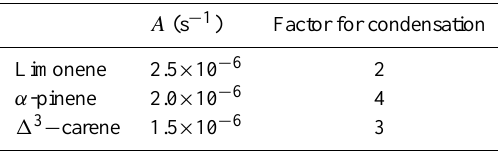
Table 7. The values of the nucleation coefficient (A) and the factor for condensation for the simulations with the MALTE